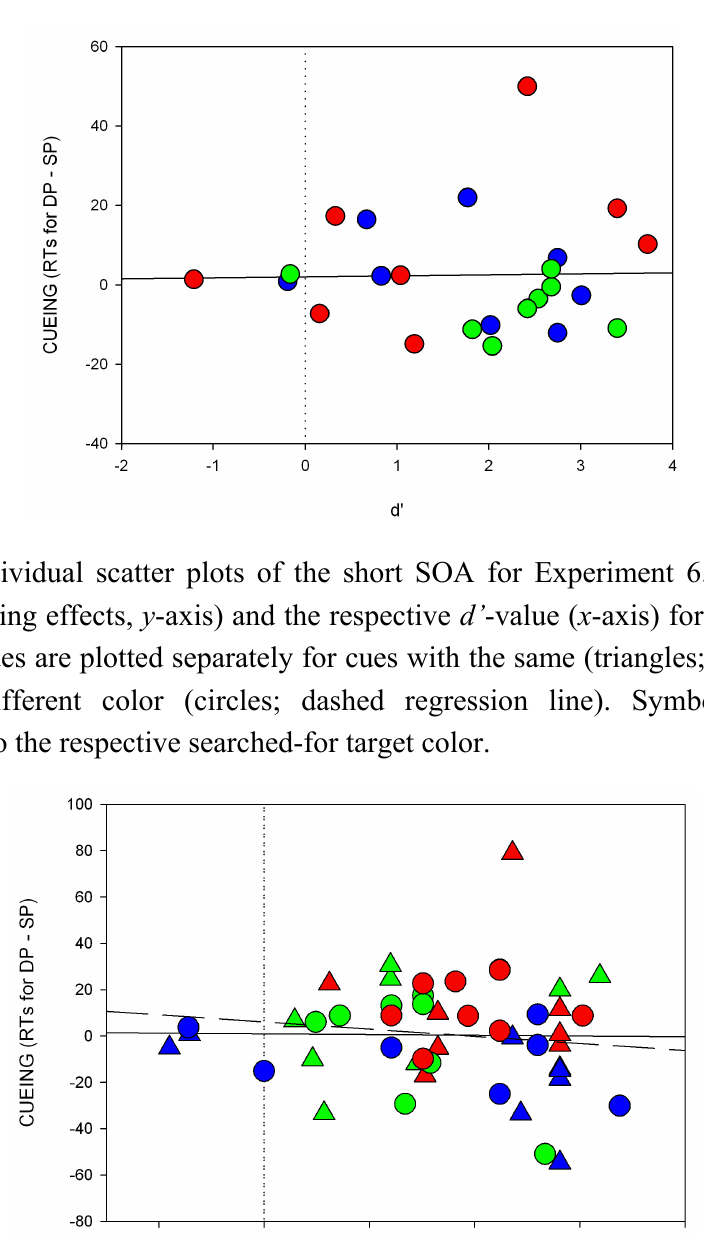
Figure A5. Individual scatter plots for Experiment 5. Shown are RT differences (cueing, y -axis) and the respective d’ -value ( x -axis) of the short SOA for each participant separately. The colors of the circles correspond to the respective searched-for target color.